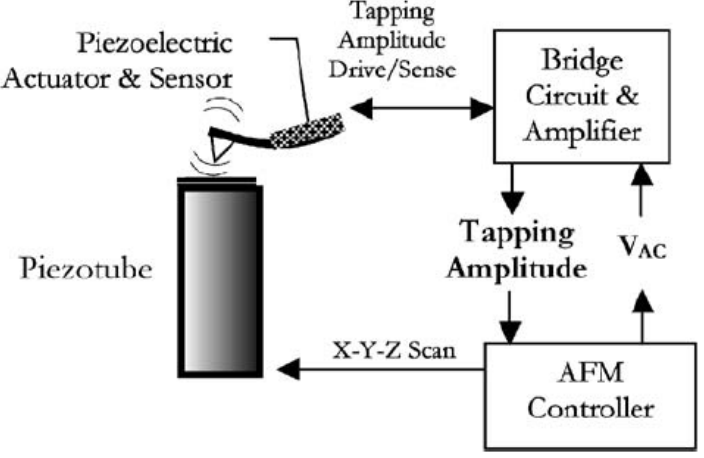
Figure 7. Schematic of an Atomic Force Microscope (AFM) with a piezoelectric sensor and actuator